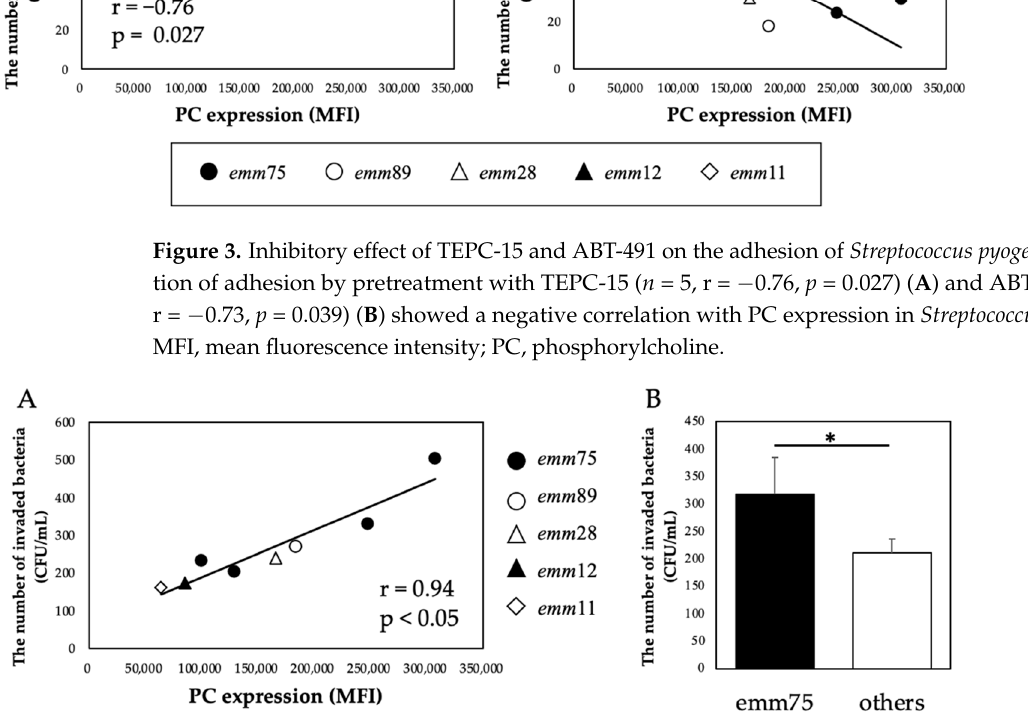
Figure 3. Inhibitory effect of TEPC-15 and ABT-491 on the adhesion of Streptococcus pyogenes. Inhi- bition of adhesion by pretreatment with TEPC-15 ( n = 5, r = − 0.76, p = 0.027) ( A ) and ABT-491( n = 5, r = − 0.73, p = 0.039) ( B ) showed a negative correlation with PC expression in Streptococcus pyogenes . MFI, mean fluorescence intensity; PC, phosphorylcholine.